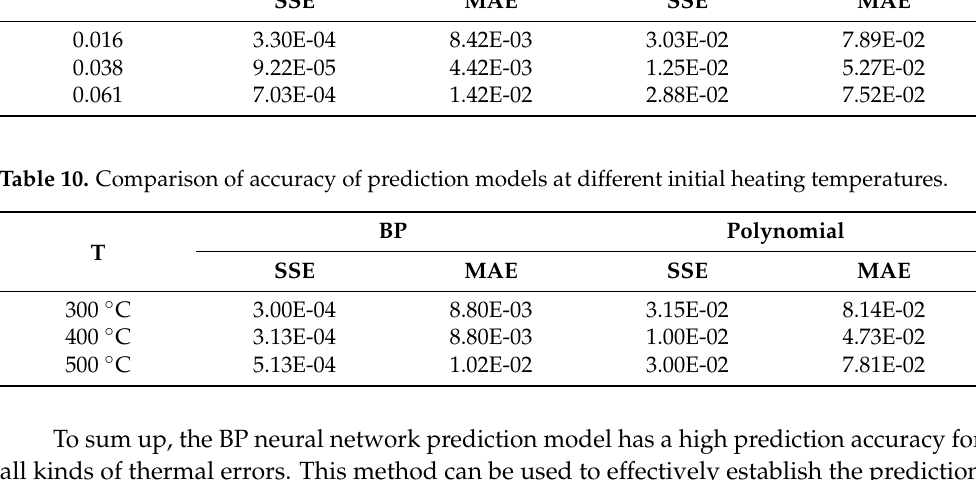
Table 9. Comparison of accuracy of prediction models at different water velocities. v /m/s